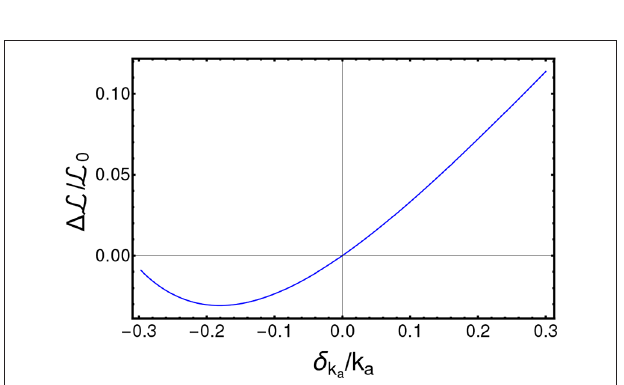
FIGURE 8 | Robustness analysis with respect to systematic errors. Relative variation of the cost 1 L / L 0 with respect to the relative value of the systematic / k a error δ k a